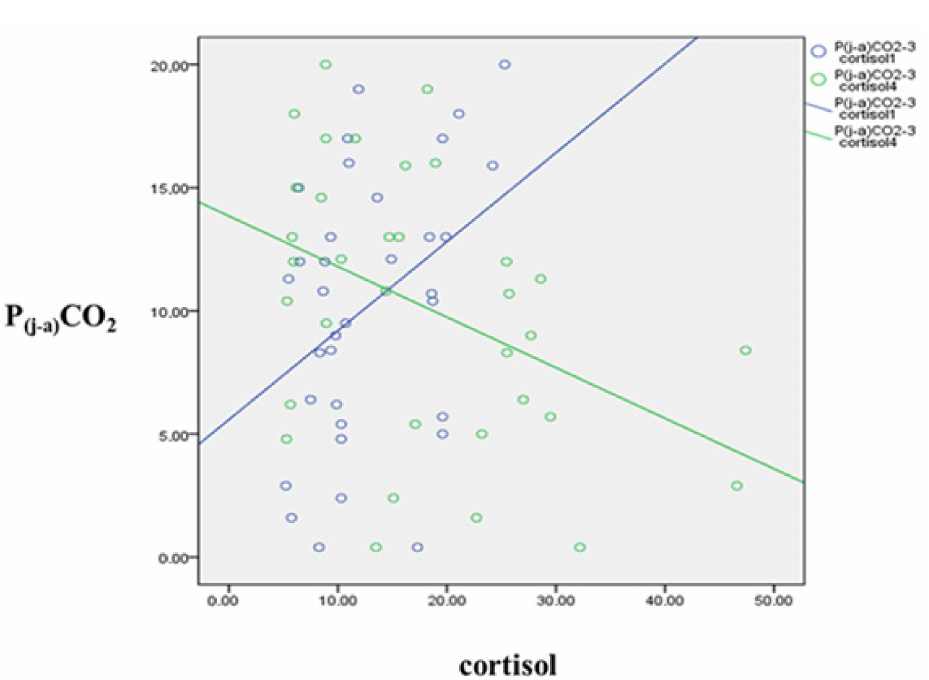
Figure 2. Scatter plot showing a correlation between P(j-a)CO 2 (mm Hg) and cortisol (nmol/L) levels before and after the operation. The circles represent the plotted values for each of the variables while the lines represent the best fit for the correlation between them. Blue line represents the correlation of P(j-a)CO 2 before release of clamp and preoperative cortisol, Green line represents the correlation of P(j-a)CO 2 before release of clamp and cortisol 2 h after the operation. 3.4. S100B’s Relation to Jugulo-Arterial Carbon Dioxide Gap (P(j-a)CO 2 ) and